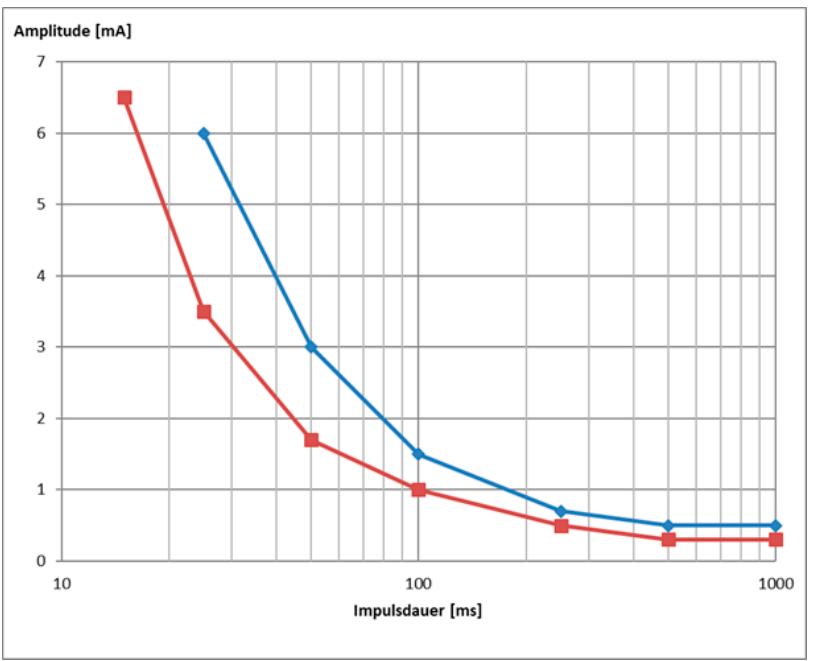
Figure 5. Example of a strength duration curve of patient DFP0101001 at 4 weeks follow up for single pulse stimulation delivered with triangular (blue) or rectangular (red) waveform (data are shown in Figure 6).